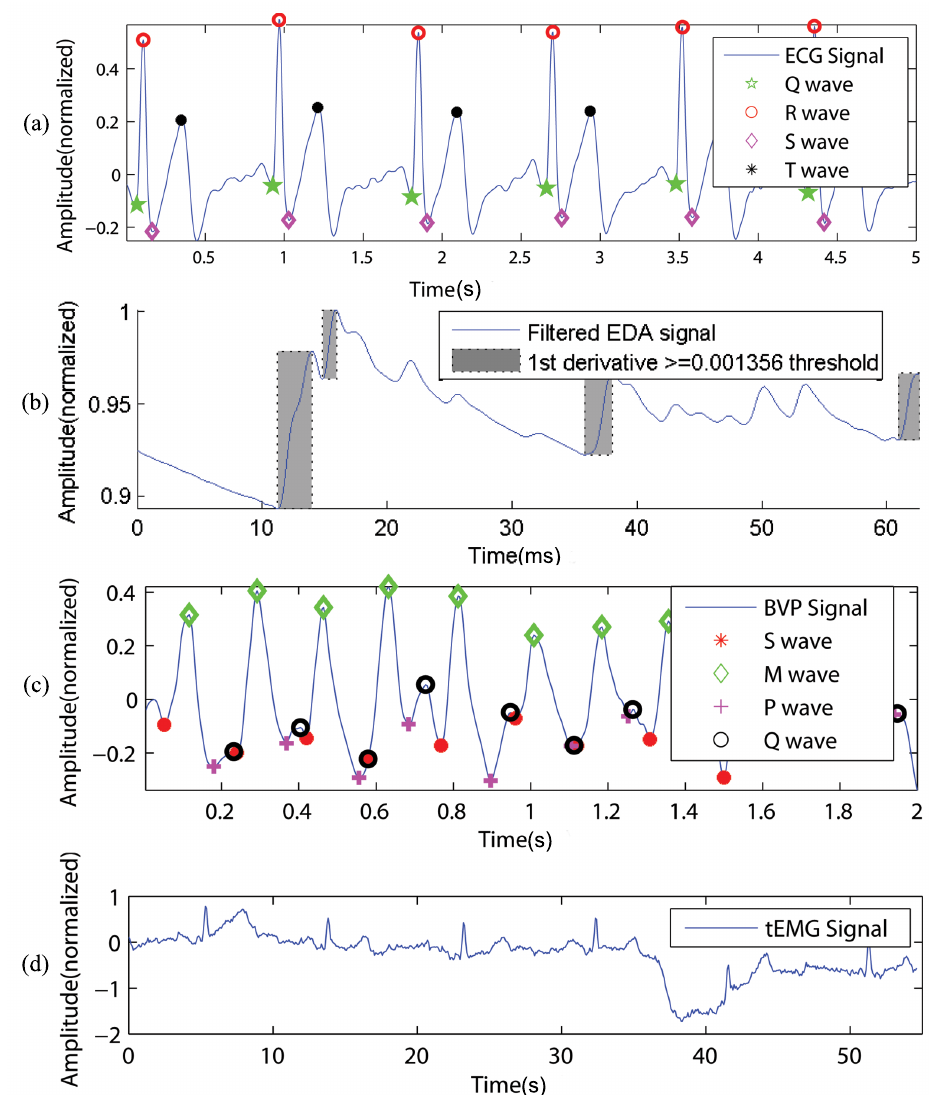
Figure 7. Preprocessed and extracted feature of ( a ) ECG; ( b ) EDA; ( c ) BVP and ( d ) EMG